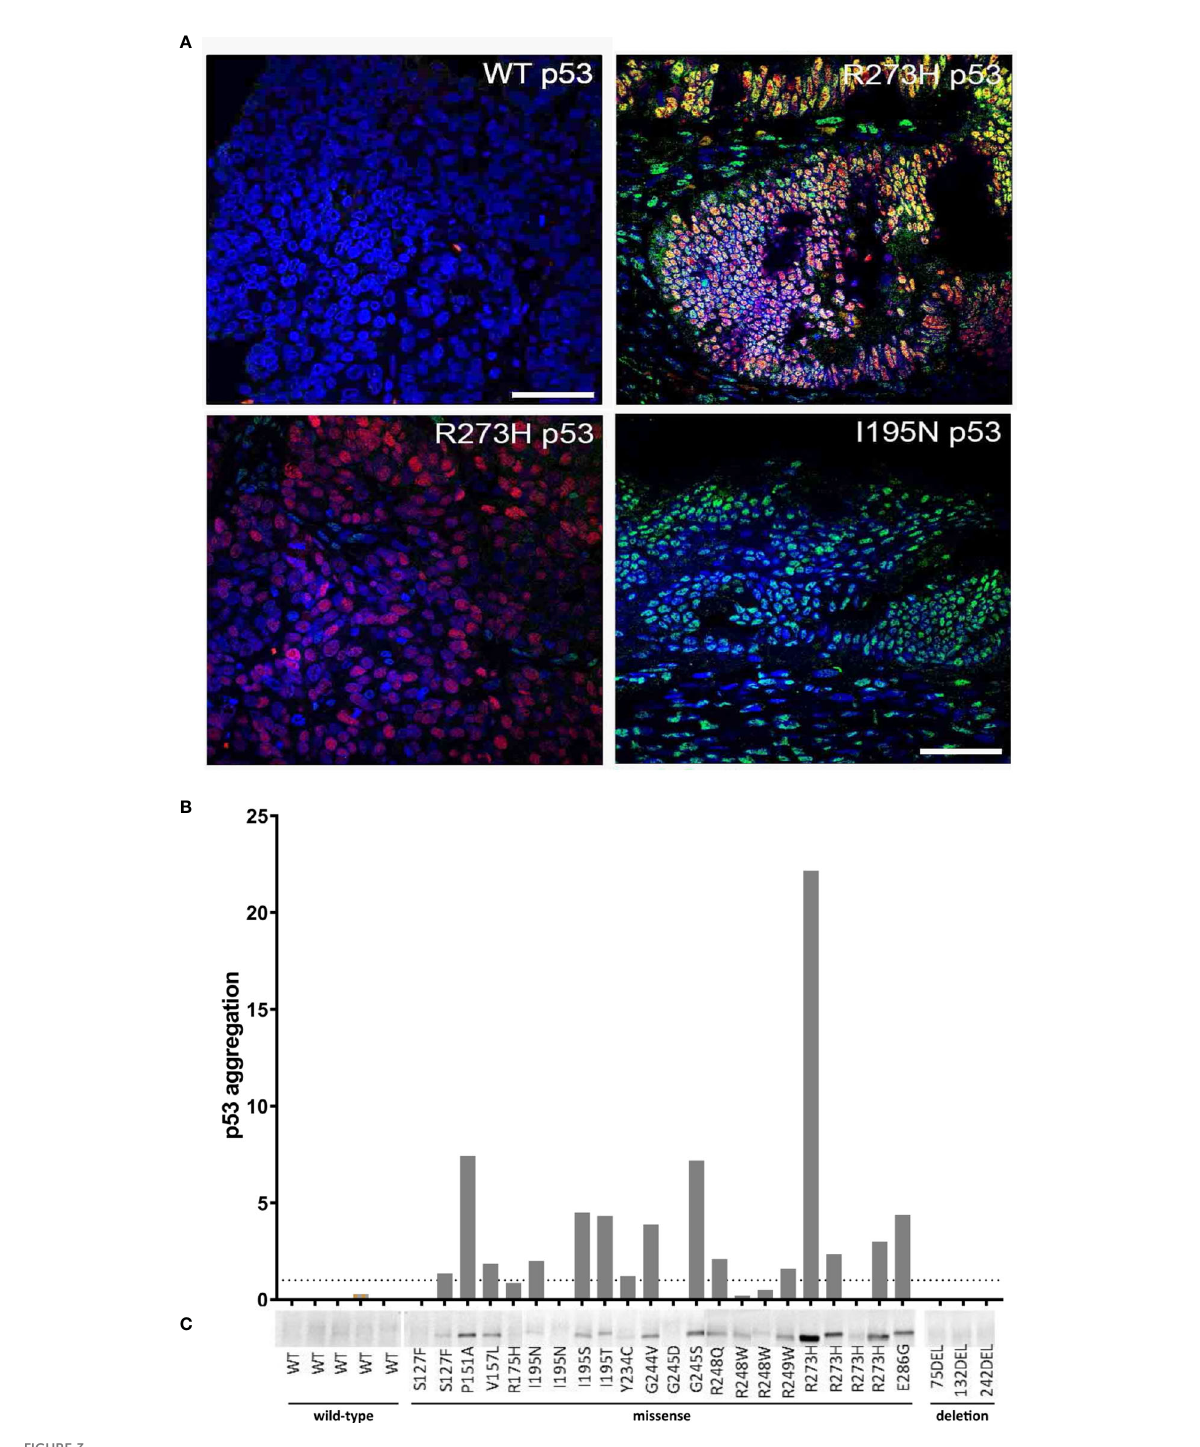
FIGURE 3 Detection of p53 aggregates in ovarian cancer (OC) tissue specimens. (A) Four representative OC FFPE tissue samples, which were analyzed by co-IF using an anti-p53 (red) and anti-amyloid (A11, green) antibody' are shown. Nuclear counterstaining was performed using DAPI. Scale bar = 50 µm. (B) Detection of p53 aggregates in 30 fresh-frozen OC tissue samples by using the p53-Seprion-ELISA. Absorbance values were normalized to the total protein concentration Dashed line, cut-off value for positive samples (p53 aggregation >1). (C) Co-IP was performed by using the anti-oligomer A11 antibody for the pull-down of amyloid proteins. Immunoblots for p53 were performed to show that the amyloid oligomers consisted of